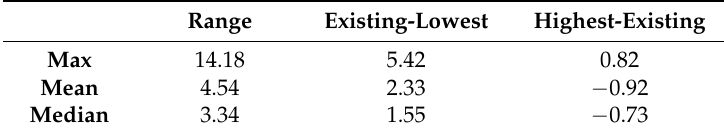
Table 1. Summary of sensitivity test of 14 Waste ‐ water treatment facilities in Rhode Island. “Existing ‐ lowest” refers to the lowest existing point tested minus the lowest elevated vulnerability on site.